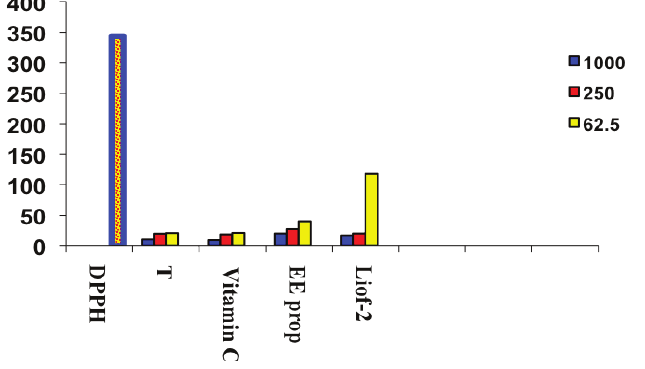
FIGURE 5 - DPPH radical scavenging activity of freeze-dried propolis – Liof-2 (WSDP) and propolis ethanol extract (EE prop) in natura .